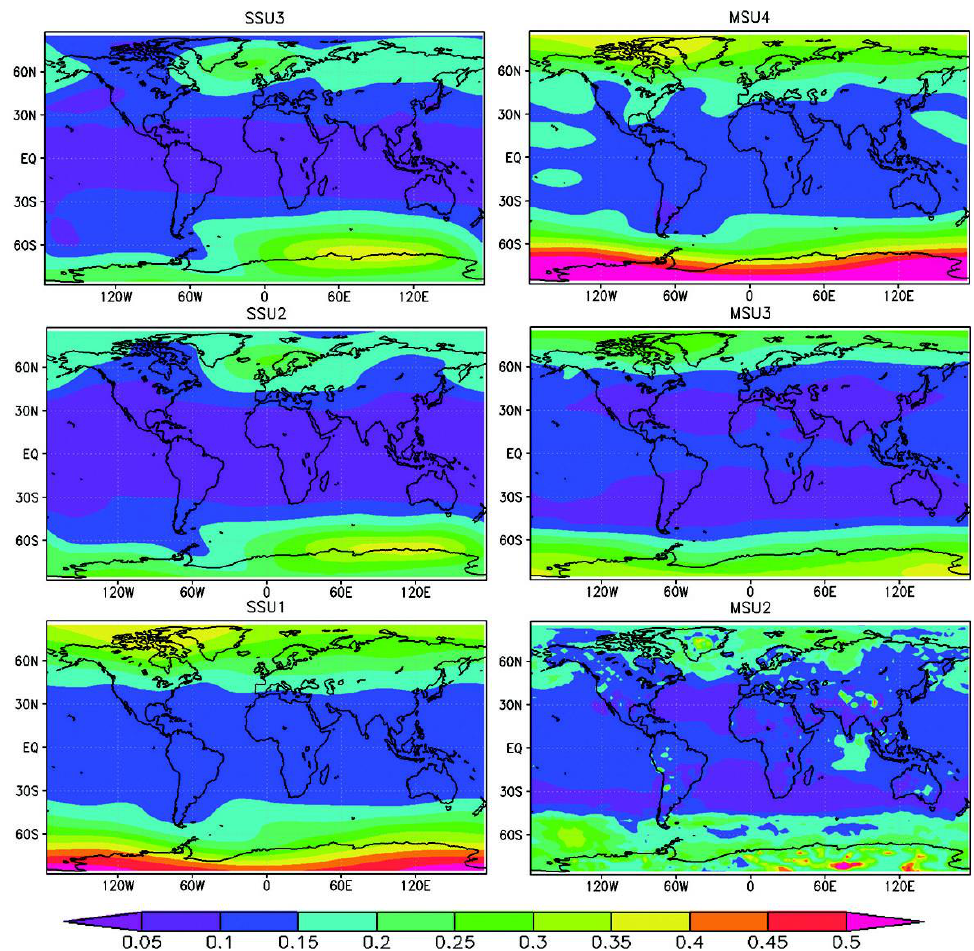
Figure 6. Spatial distribution of spread of temperature trends in CMIP5 model simulations. Note SSU1-3 and MSU2-4 represent the SSU/MSU observational layers (unit K/de).